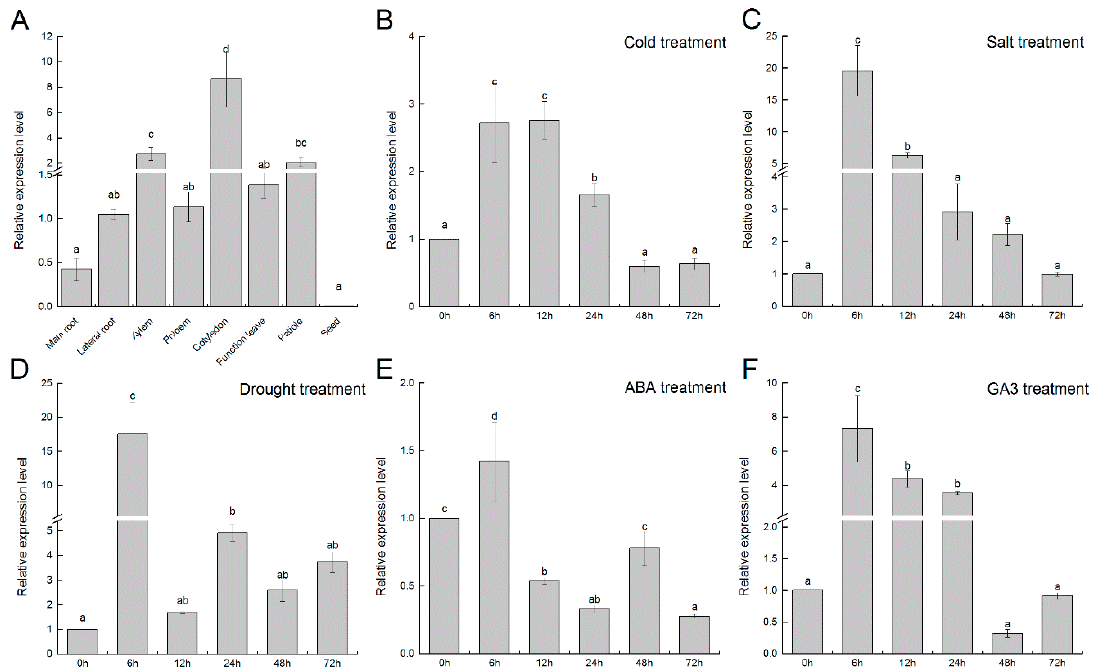
Figure 4. Expression patterns of FmTCP15 . ( A ) Expression patterns of FmTCP15 gene in different tissues. ( B – F ) Expression patterns of FmTCP15 under different stress and hormone signal treatments: ( B ) cold (4 °C), ( C ) salt (200 mm/L NaCl), ( D ) drought (20% w/v PEG6000), ( E ) abscisic acid (100 μ mol/L ABA), and ( F ) gibberellic acid (100 μ mol/L GA3). Different letters above bars within statistically significant differences between different times of the treatments at the p < 0.05 level according to Duncan's multiple range test.